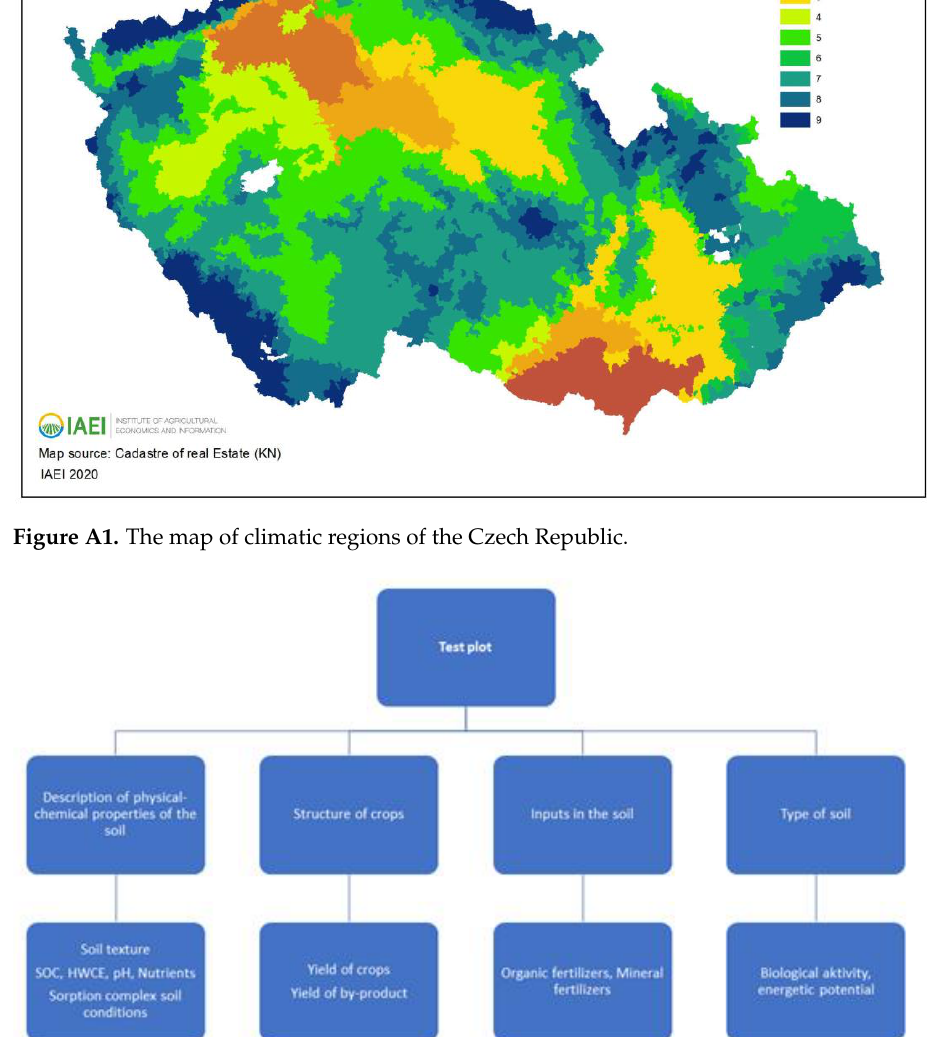
Figure A2. The basic structure monitoring. Source: MDPI [69].